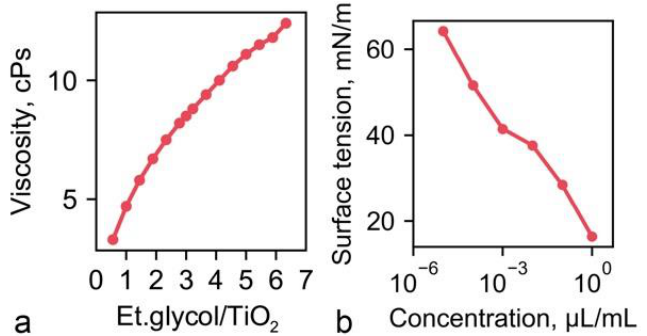
Figure 5. Rheological parameters of inks: viscosity curve of ethylene glycol/water colloid of titania nanoparticles ( a ), values of surface tension under different surfactant concentrations ( b ). Table 3. Main parameters of the prepared